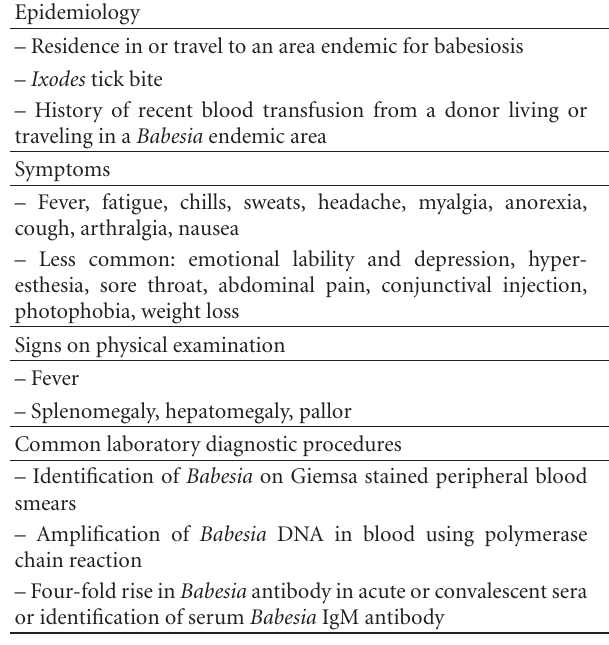
Table 2: Diagnosis of